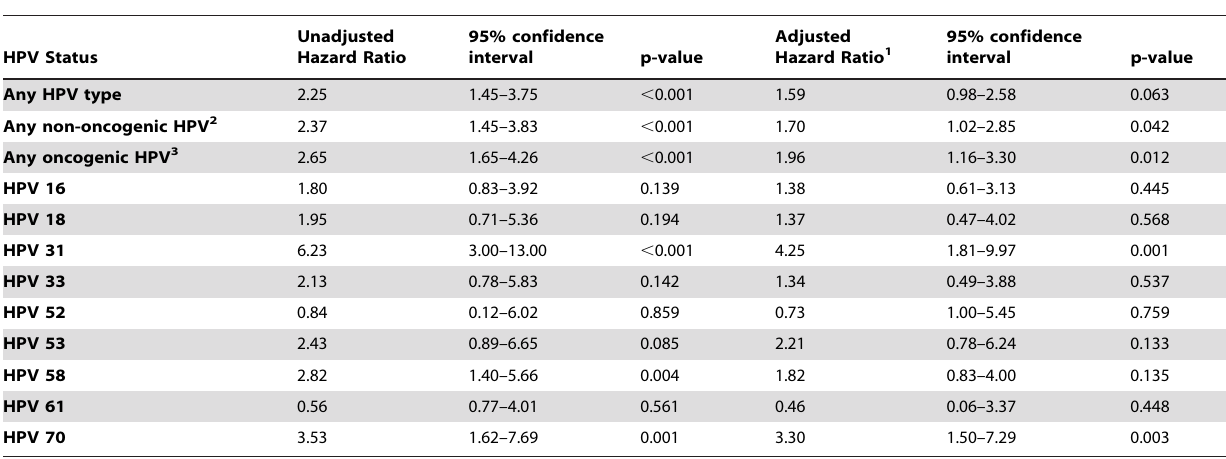
Table 4. Concurrent HPV infection as a predictor of HIV